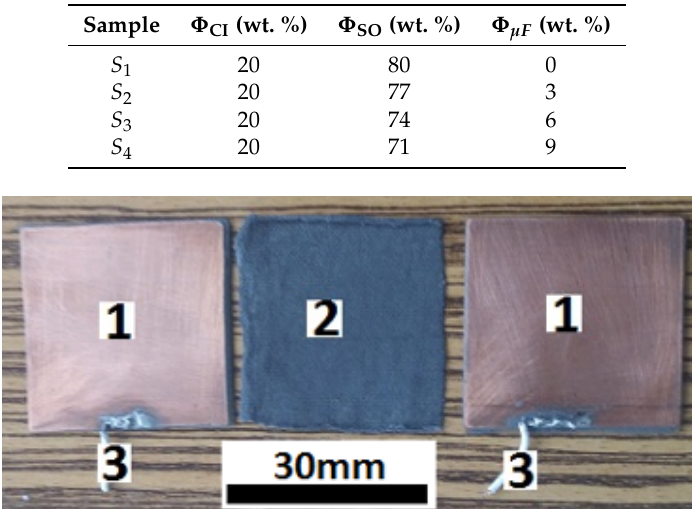
Table 1. The mass fractions Φ CI , Φ SO , and Φ µ F of CI, SO, and respectively of µ F inside the liquid solutions S i , i = 1,2,3,4.